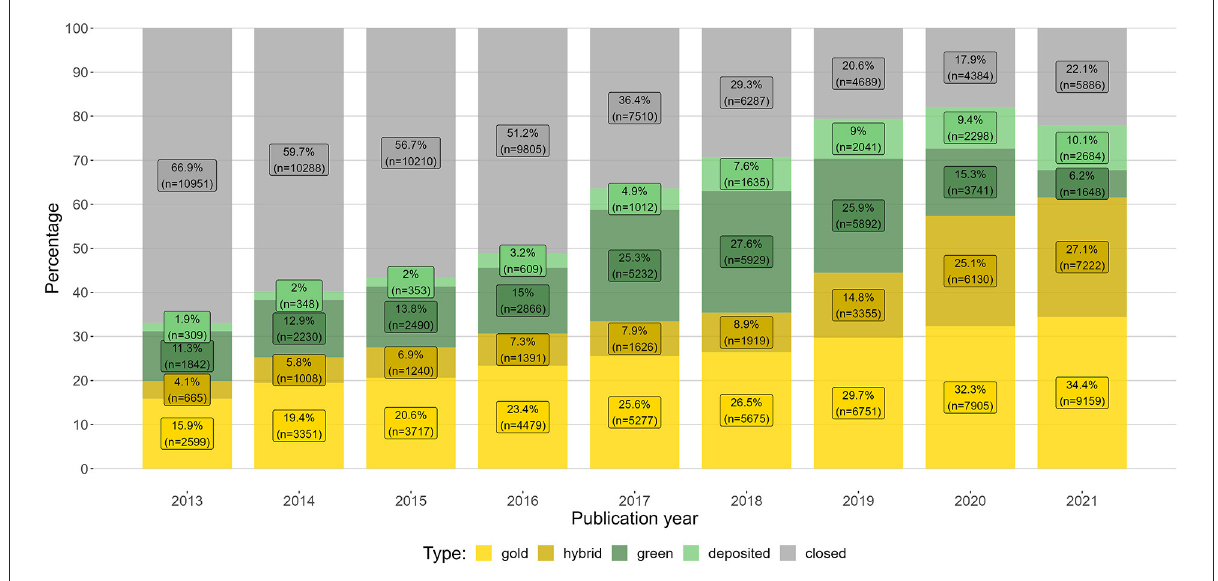
FIGURE3 The distribution of Norwegian journal articles’ open access status in the period 2013–2021, with shares of gold, hybrid, green, deposited, and closed articles. The plot is separated on the four main research areas.